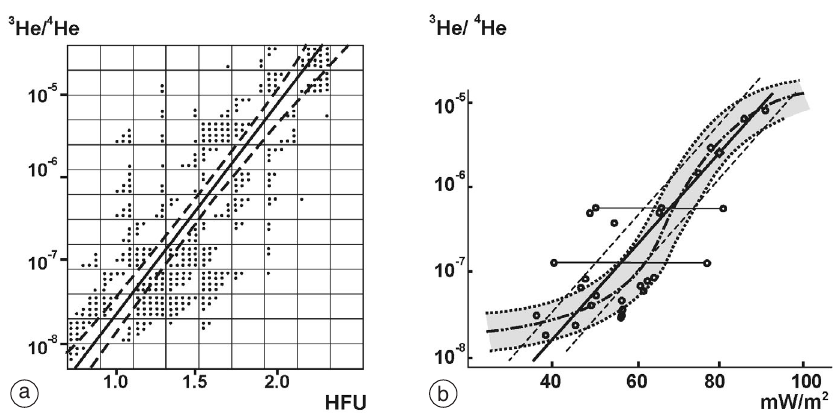
a b Fig. 3a,b. Heat flow- 3 He/ 4 He dependence, inter-regional juxtapositions. a) the plot of individual 3 He/ 4 He values versus background heat flow density in the FSU area from (Polyak et al. , 1979a); b) the relation of background 3 He/ 4 He and heat flow density values in different tectonic units of the Northern Eurasia from (Polyak, 1988). 12